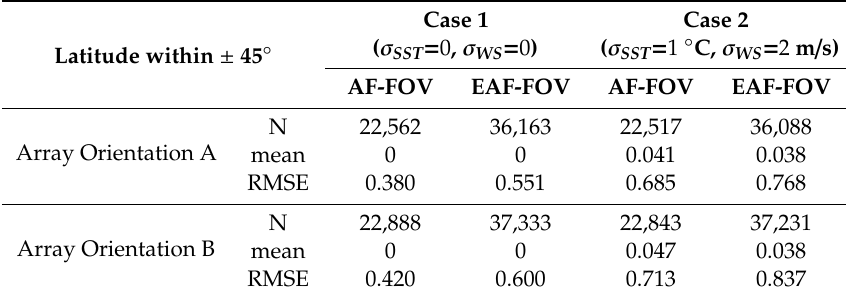
Table 3. The statistics of SSS retrieval accuracy of part of the pass with latitude with ± 45 ◦ for di ff erent array orientations of case 1 and case